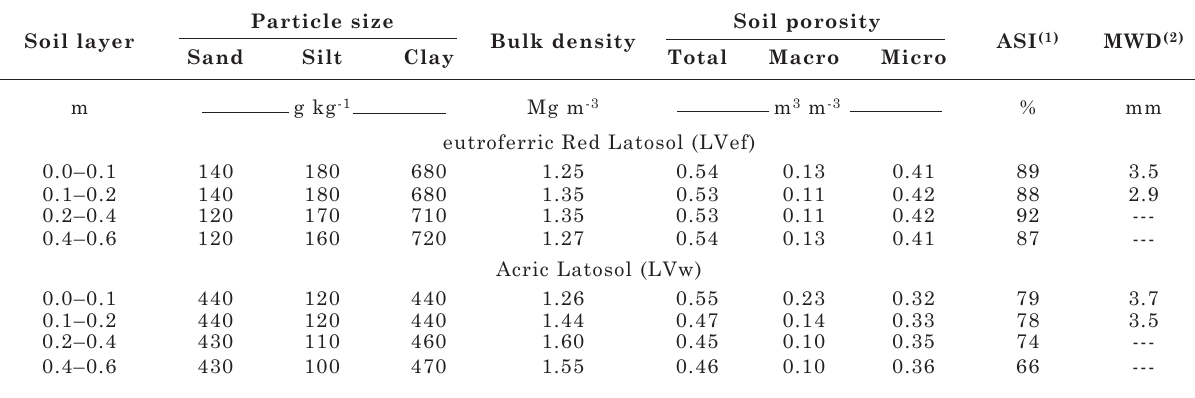
table 2. Soil physical properties prior to the experiment